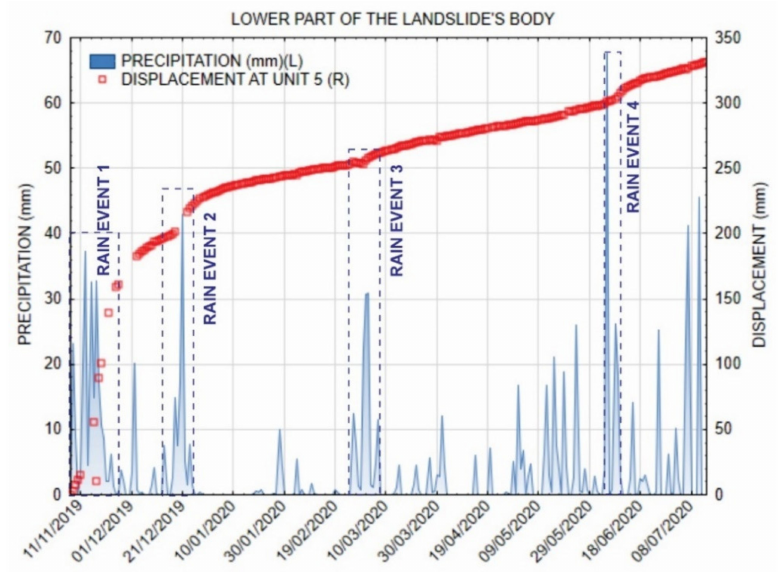
Figure 15. Landslide behaviour at the lowest part is strongly correlated with the precipitation